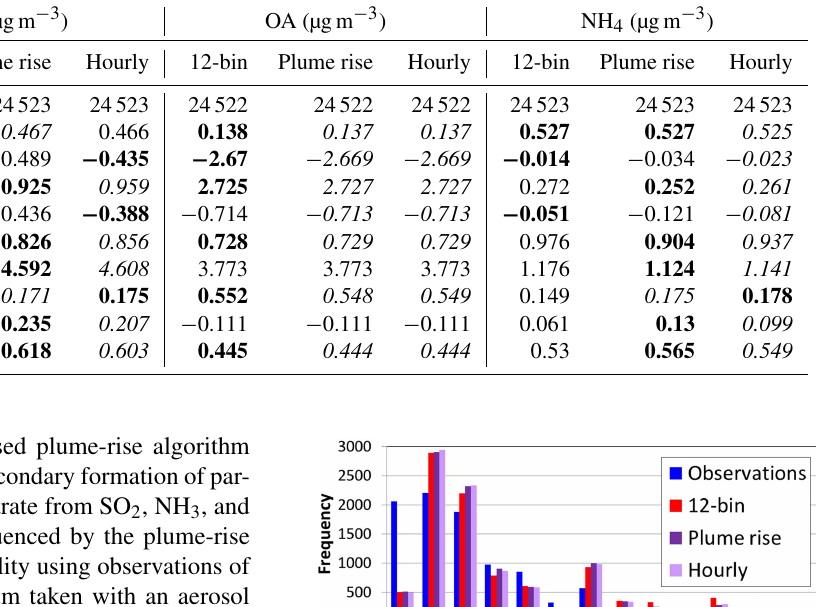
Table 4. Statistical comparison of PM 1 sulfate, OA, and ammonium atmospheric concentration from the aircraft AMS with the 2.5km resolution GEM-MACH simulations between 13 August and 9 September 2013. Boldface type indicates best score; italics indicates second best score.